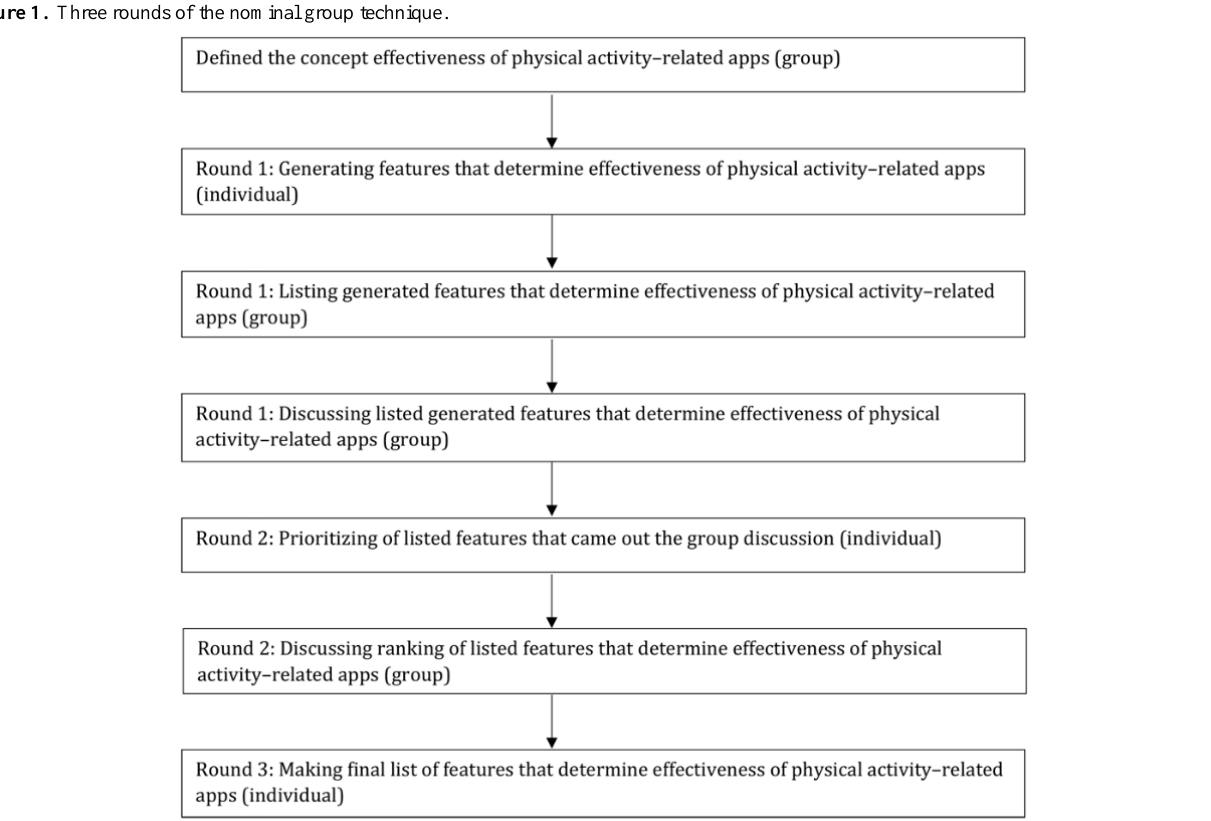
Figure 1. Three rounds of the nominal group